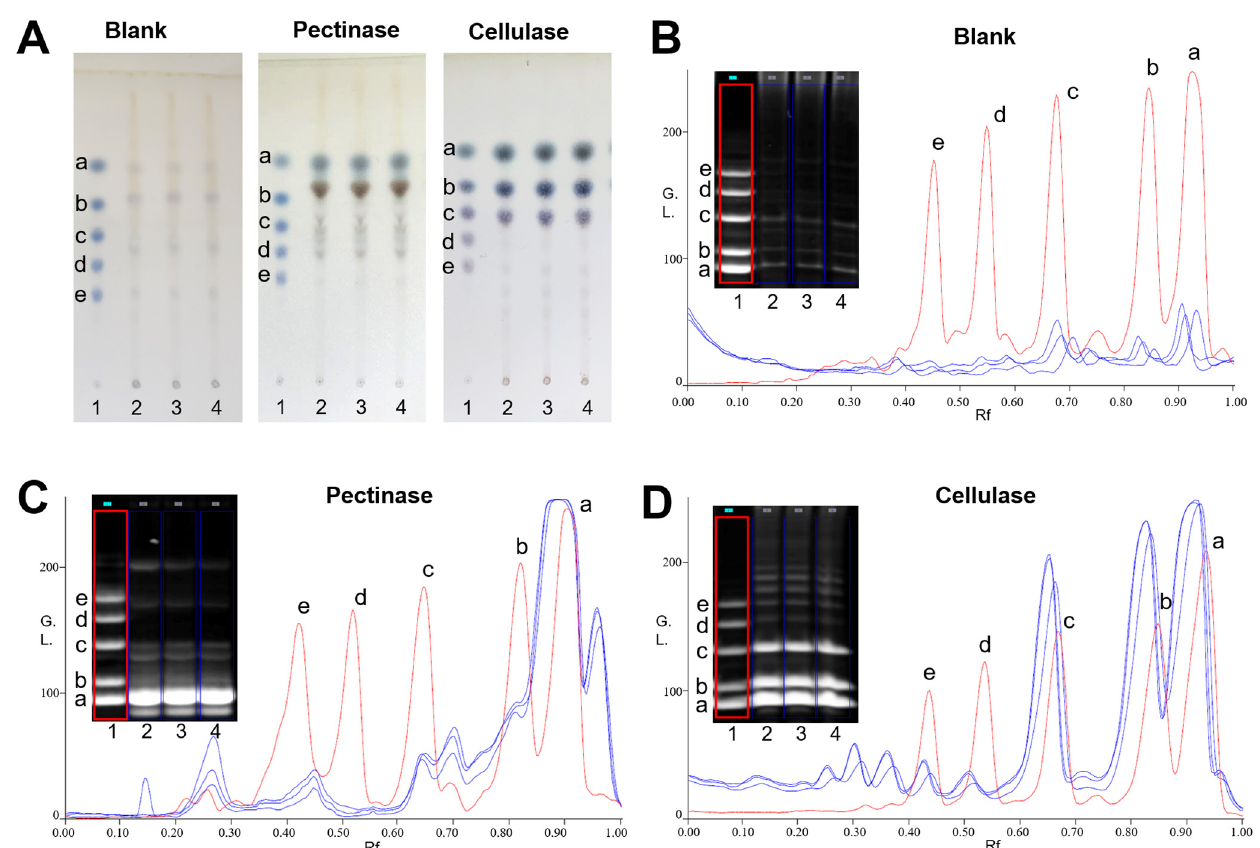
Figure 1. HPTLC profiles ( A ) and PACE fingerprints and chromatograms ( B – D ) of enzymatic hy- drolysates of PPZM. Oligosaccharide standards (1), enzymatic hydrolysates of PPZM by corresponding enzymes (2–4). D-glucose (a), maltose (b), maltotriose (c), malttetraose (d) and maltpentose (e).